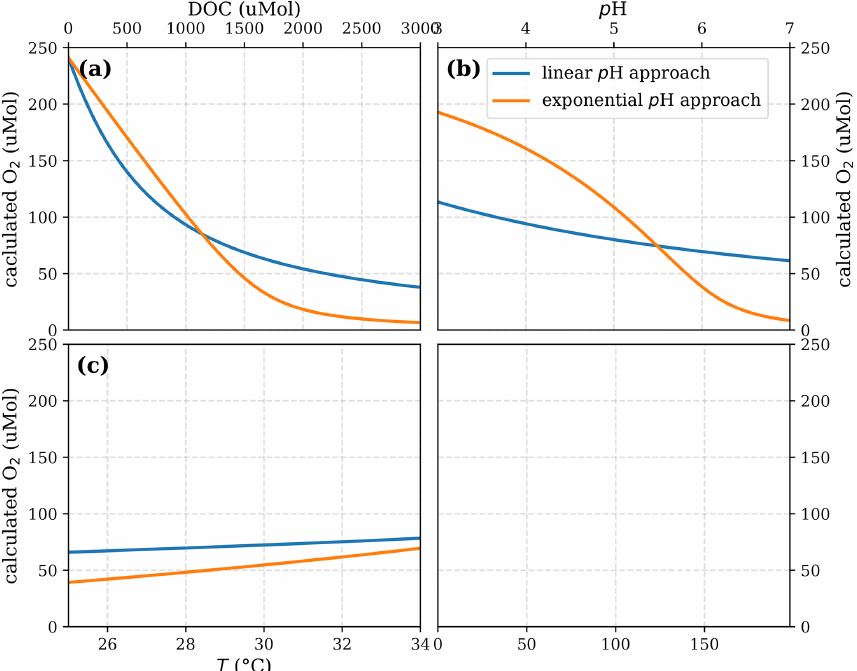
Figure A3. Functional dependencies of O 2 on (a) DOC, (b) pH, and (c) temperature ( T ) according to the equation in Table 1 (linear pH approach) and in Table 2 (exponential pH approach).